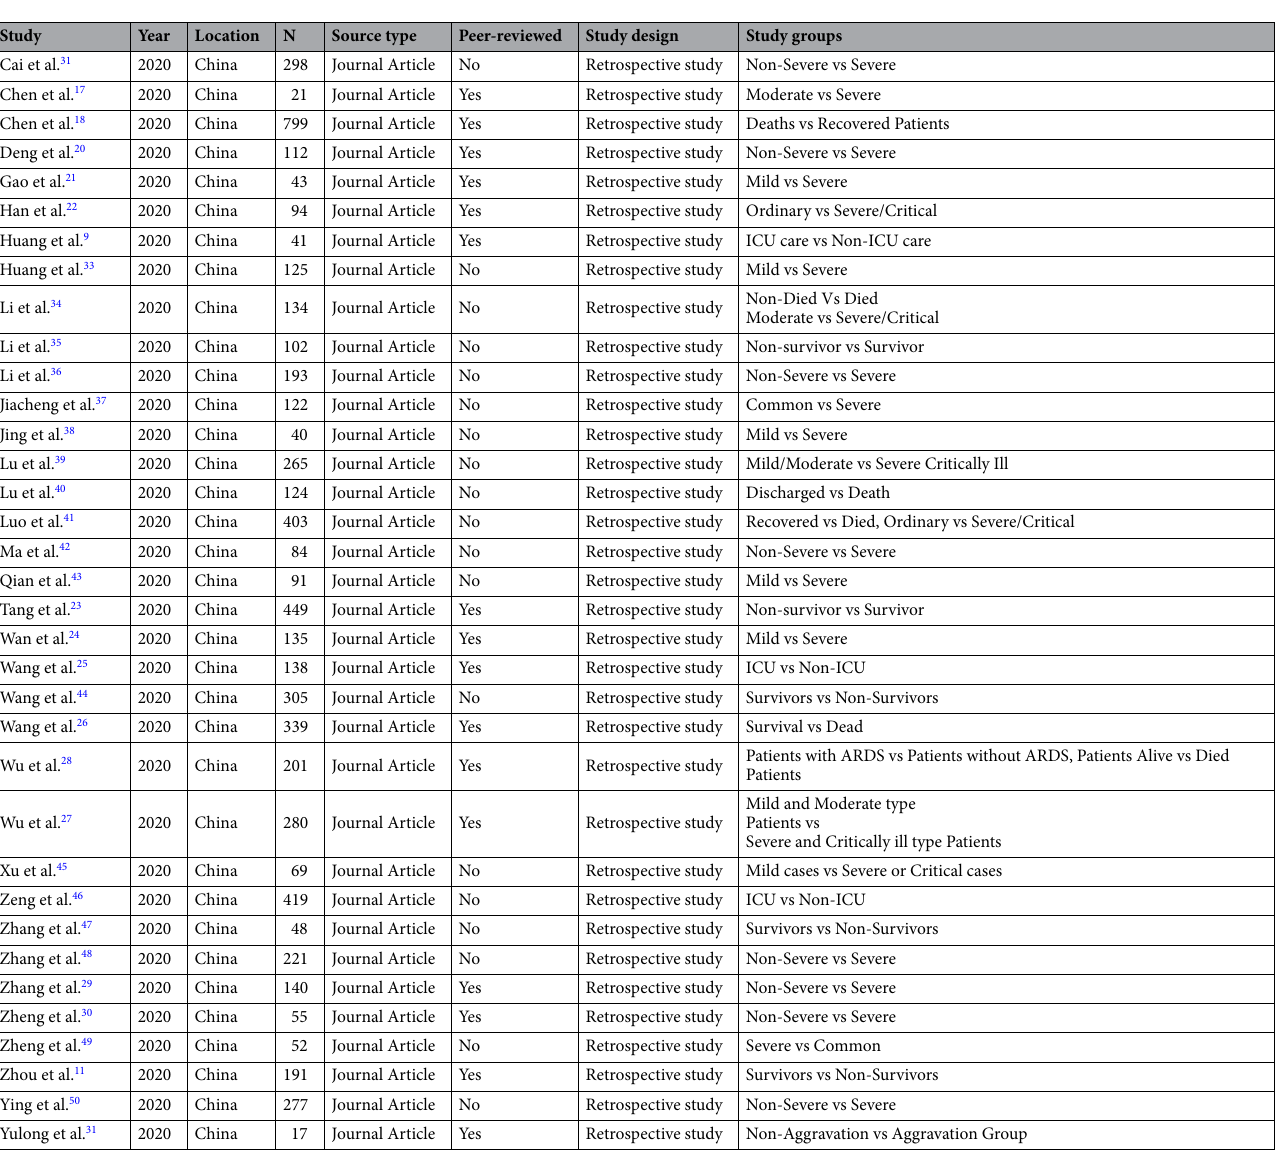
Table 1. Characteristics of the studies included in the